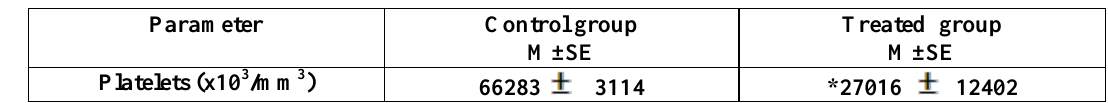
Table (6) Effect of E coli infection on mean of Platelets